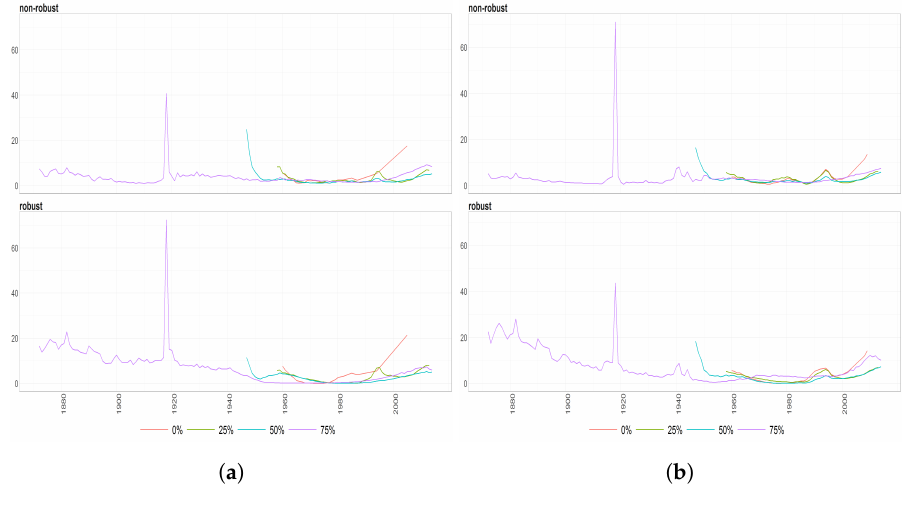
Figure 17. The Mahalanobias distances obtained using PPCA for Females ( a ) and Males ( b ) of Number of Death over time (x axis). Different colours of lines correspond to the cases of different percentages of maximal missing entries in rows (light blue (75%), dark brown (50%), dark blue (25%), light brown (0%)). Every subfigure is divided into two subplots corresponding to robust estimation of standard divinations (upper plot) and sample one (bottom